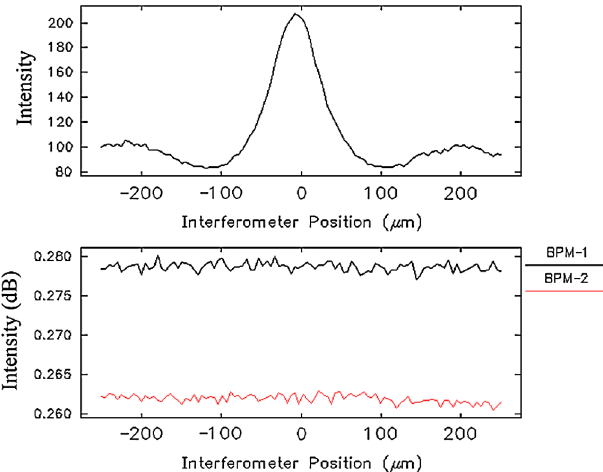
FIG. 15. (Color) FIR CTR autocorrelation performed after the chicane near maximum compression setup for the TC gun. The scan profile width (top) is about 62 (cid:1) m (FWHM). The BPM sum signals (bottom) from positions after the chicane were also tracked and show little change during the scan.